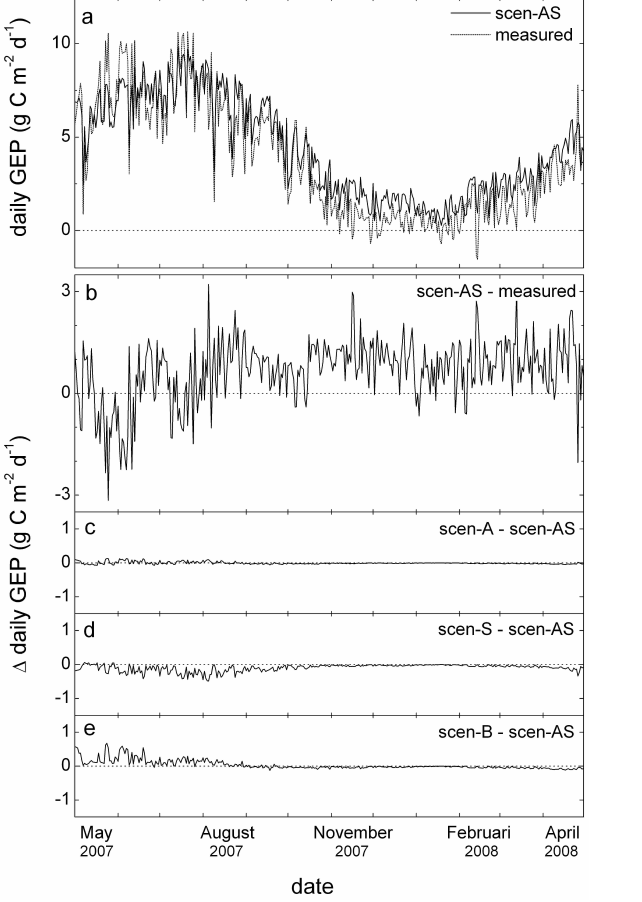
Fig. 5. Time courses of (a) daily gross ecosystem productivity (GEP) simulated under scen-AS (solid line) and measured daily GEP (short-dotted line), (b) the difference between daily GEP sim- ulated under scen-AS and measured daily GEP ( 1 daily GEP), and 1 daily GEP between scen-AS and (c) scen-A, (d) scen-S, and (e) scen-B. Scen-AS is the reference scenario, including both seasonal and needle age-related variation in V m25 and J m25 . In scen-A, only needle age-related variation is included. In scen-S, only seasonal variation is included. In scen-B, both seasonal and needle age- related variation are